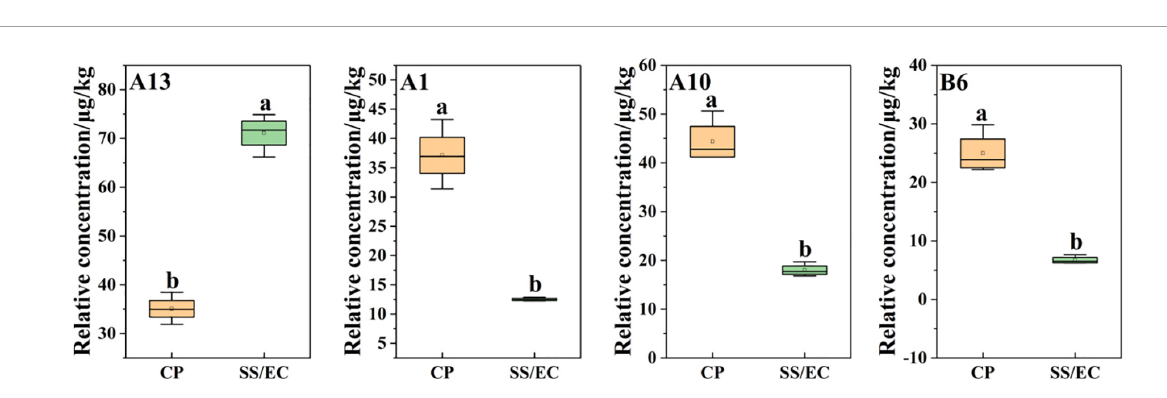
FIGURE8 Statistical analysis of differential flavor compounds related to Clitocybe squamulose chicken soup of CP vs. SS/EC